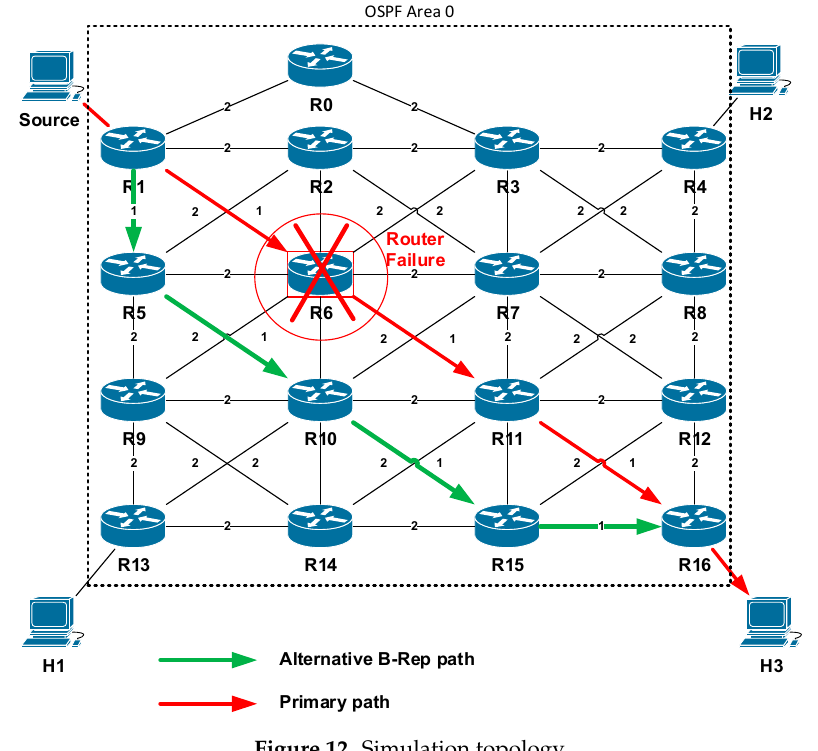
Figure 12. Simulation topology.